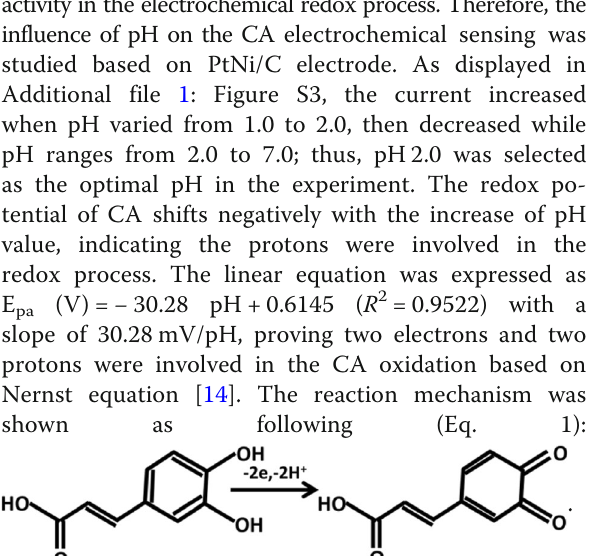
The reaction characters of CA on PtNi/C/GCE was re- corded by CVs at various scan rates in BR buffer solu- tion (pH = 2.0) containing 0.5 mM CA. As shown in Additional file 1: Figure S4, the redox peak currents in- creased linearly with the increased scan rate from 20 to 200 mVs − 1 , the linear regression equations were ob- tained as I ( μ A) = 131.472 c ( μ M) + 5.858 ( R 2 = 0.997) pa and I ( μ A) = − 152.189 c ( μ M) − 5.238 ( R 2 = 0.994), in- pc dicating a typical adsorption-controlled process. Further-